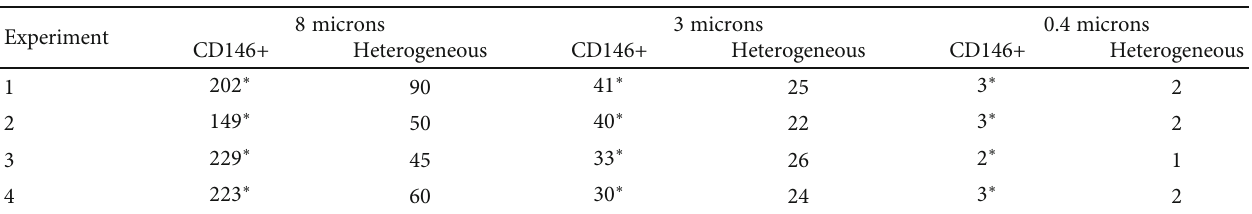
Table 1: The average number of migrated cells counted in fi ve, random fi elds at 40x light microscope magni fi cation. For 8 microns, the z -score was 2.50672. The p value was 0.01208. The result was signi fi cant at p < 0 : 05 . For 3 microns, the z -score was 2.50672. The p value was 0.01208. The result was signi fi cant at p < 0 : 05 . For 0.4 microns, the z -score was 2.08893. The p value was 0.03662. The result was signi fi cant at p < 0 : 05